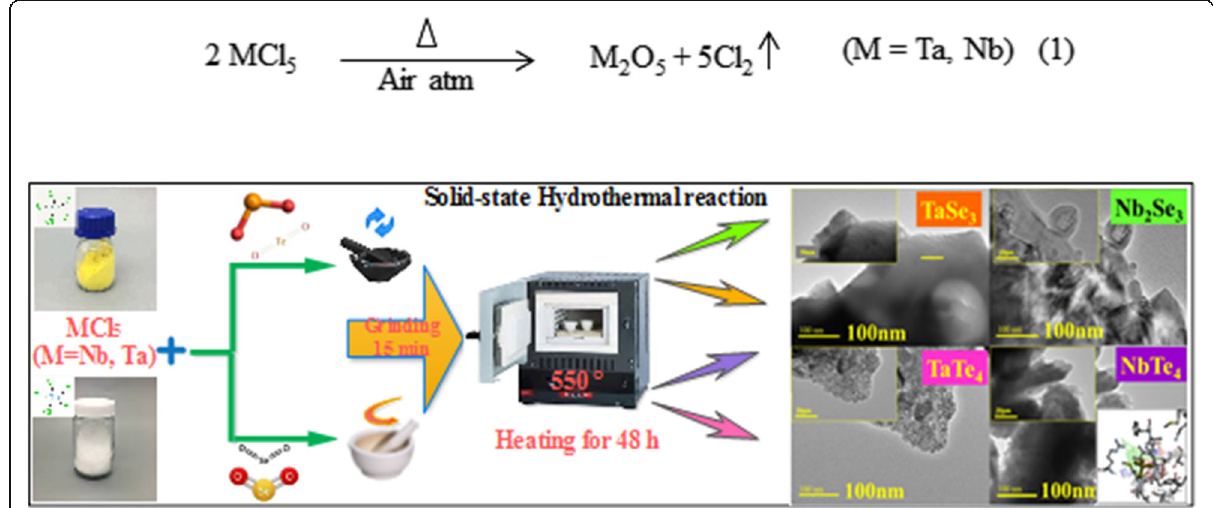
Fig. 1 Schematic diagram of synthesis of metal selenides and